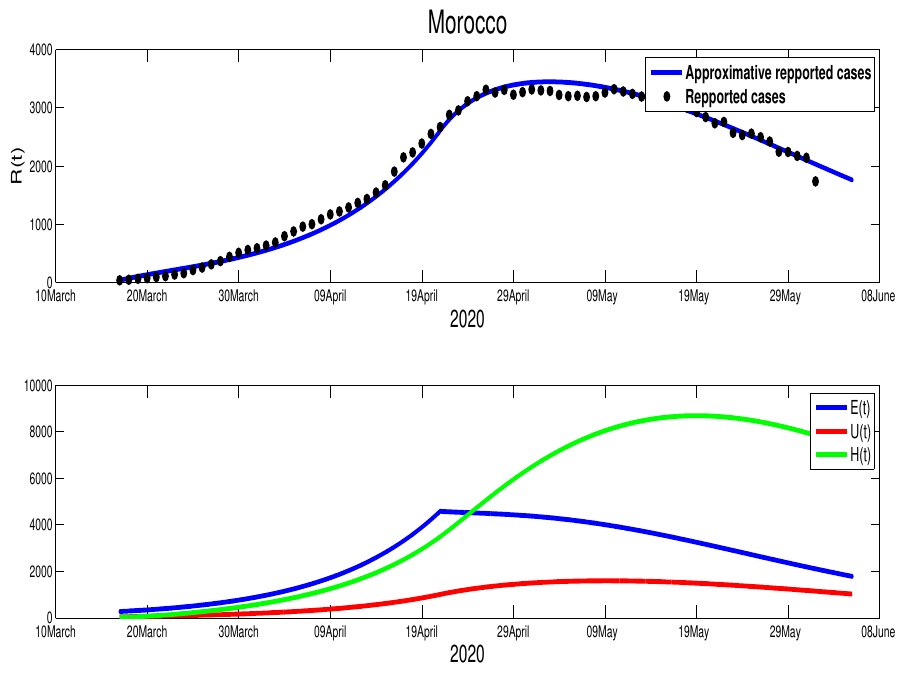
Figure 3. The data fitting of the infected reported the spread of the COVID-19 disease in